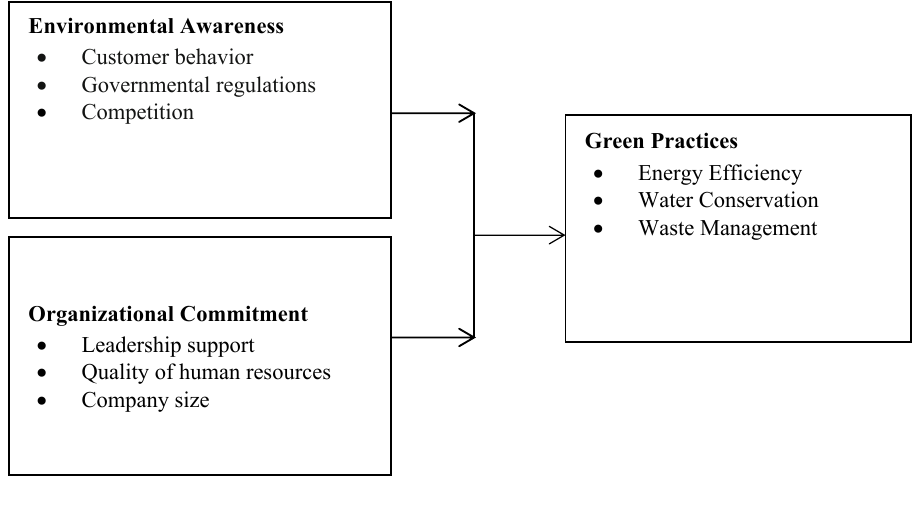
Figure 1: Conceptual